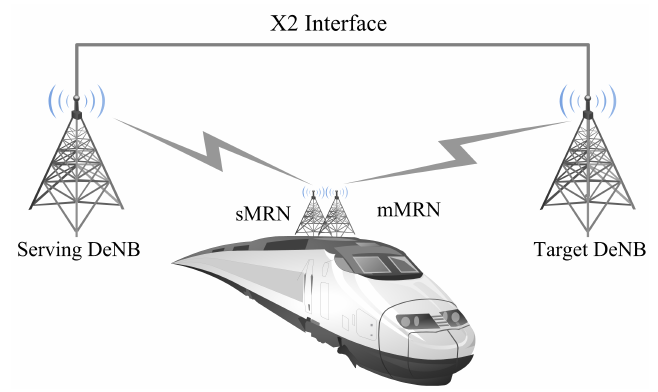
Figure 9. Proposed network model with dual MRNs. The HO procedure of mMRN is